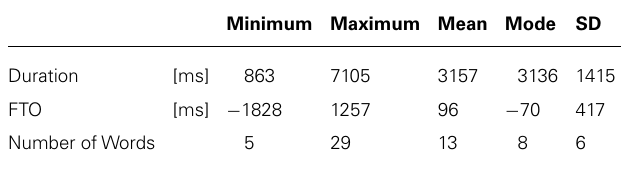
Table 2 | Descriptive statistics of target